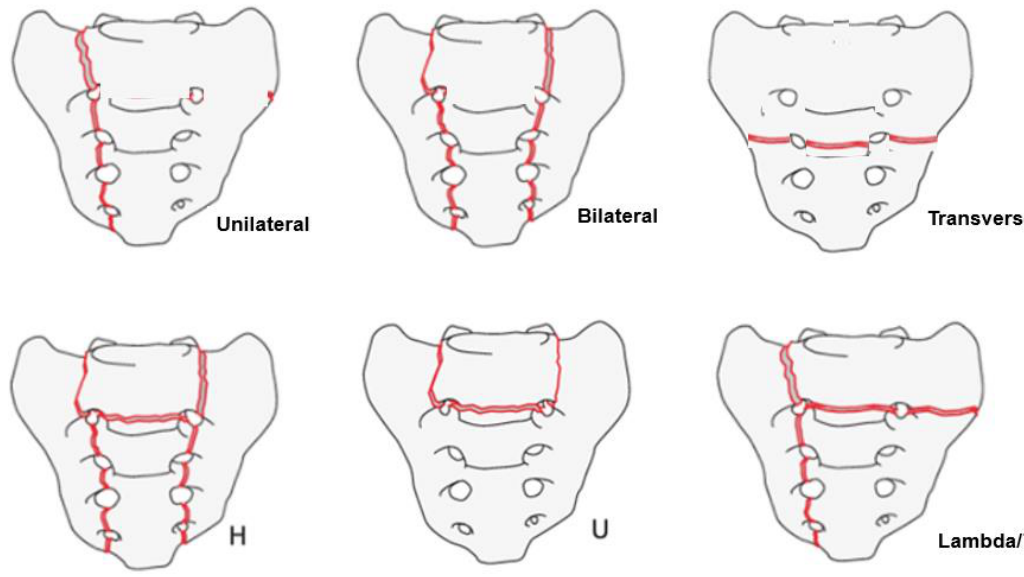
Figure 3. Fracture pattern of SIF.